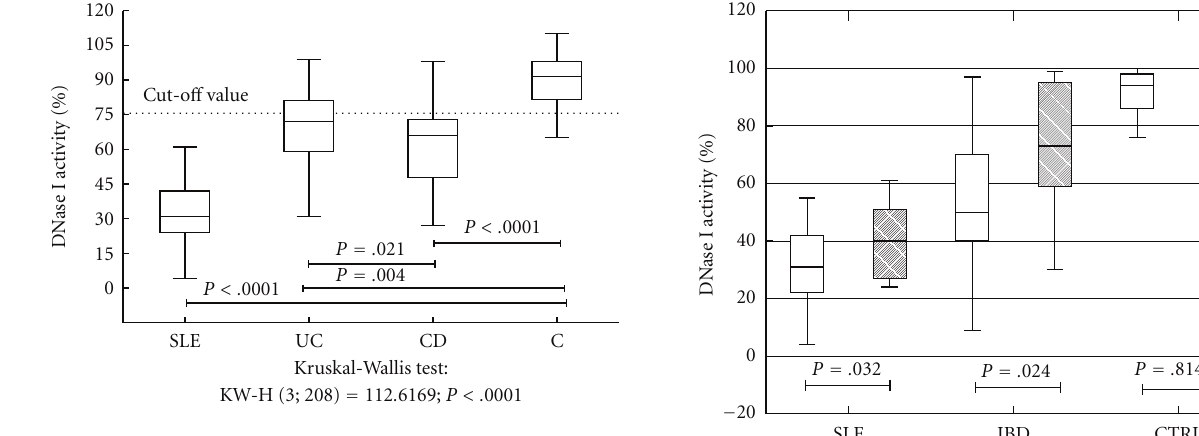
Figure 1: DNase I activity in di ff erent groups of patients. DNase I: deoxyribonuclease I; SLE: systemic lupus erythematosus; UC: ulcerative colitis; CD: Crohn’s disease; C: healthy controls. The boxplot represents the lower and upper quartiles, the horizontal line represents the median, and the whiskers represent the sample minimum and maximum. Figure 2: DNase I activity and gender. DNase I: deoxyribonuclease